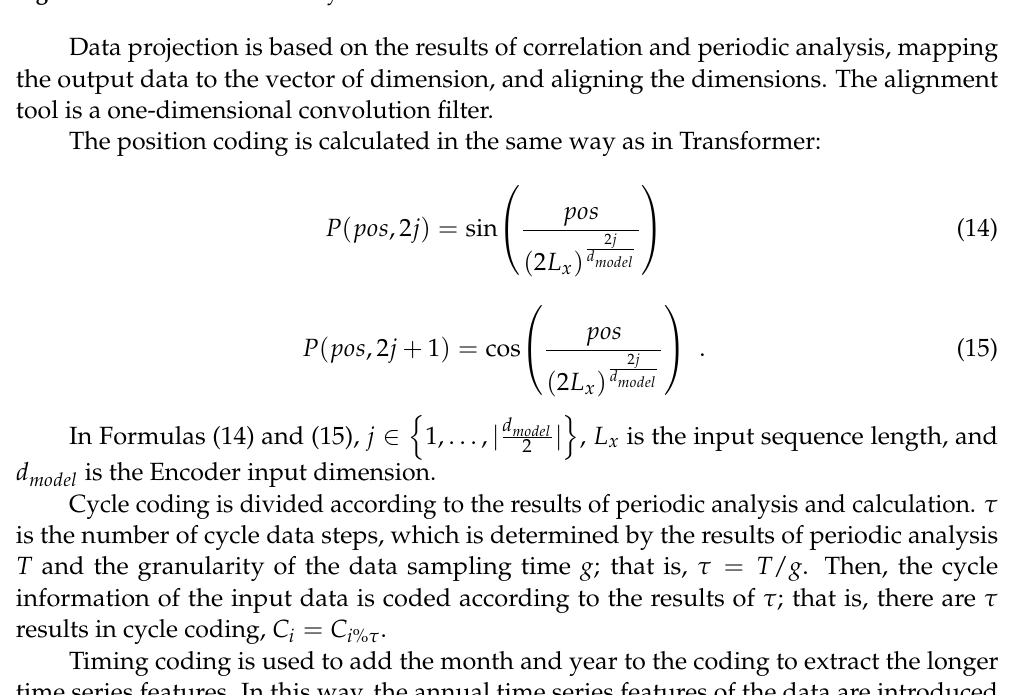
Figure 5. The structure of the CycleEmbed module.